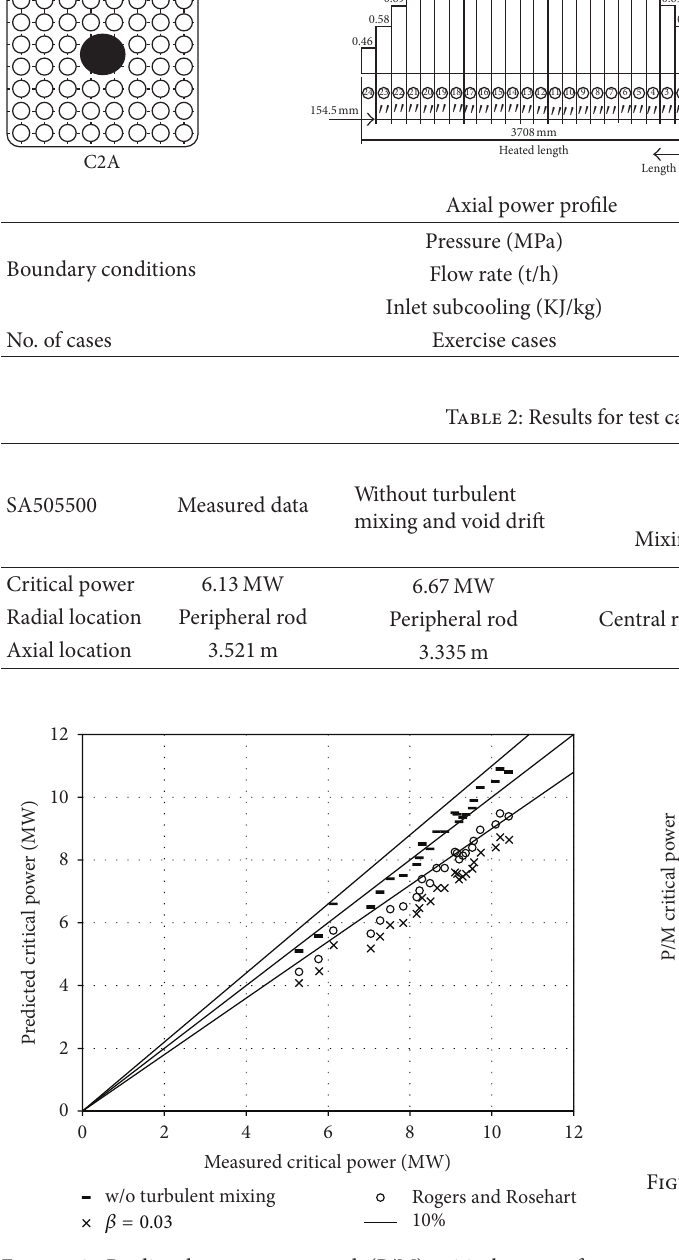
F 2: Predicted versus measured (P/M) critical power for assembly C2A with different turbulent mixing models.